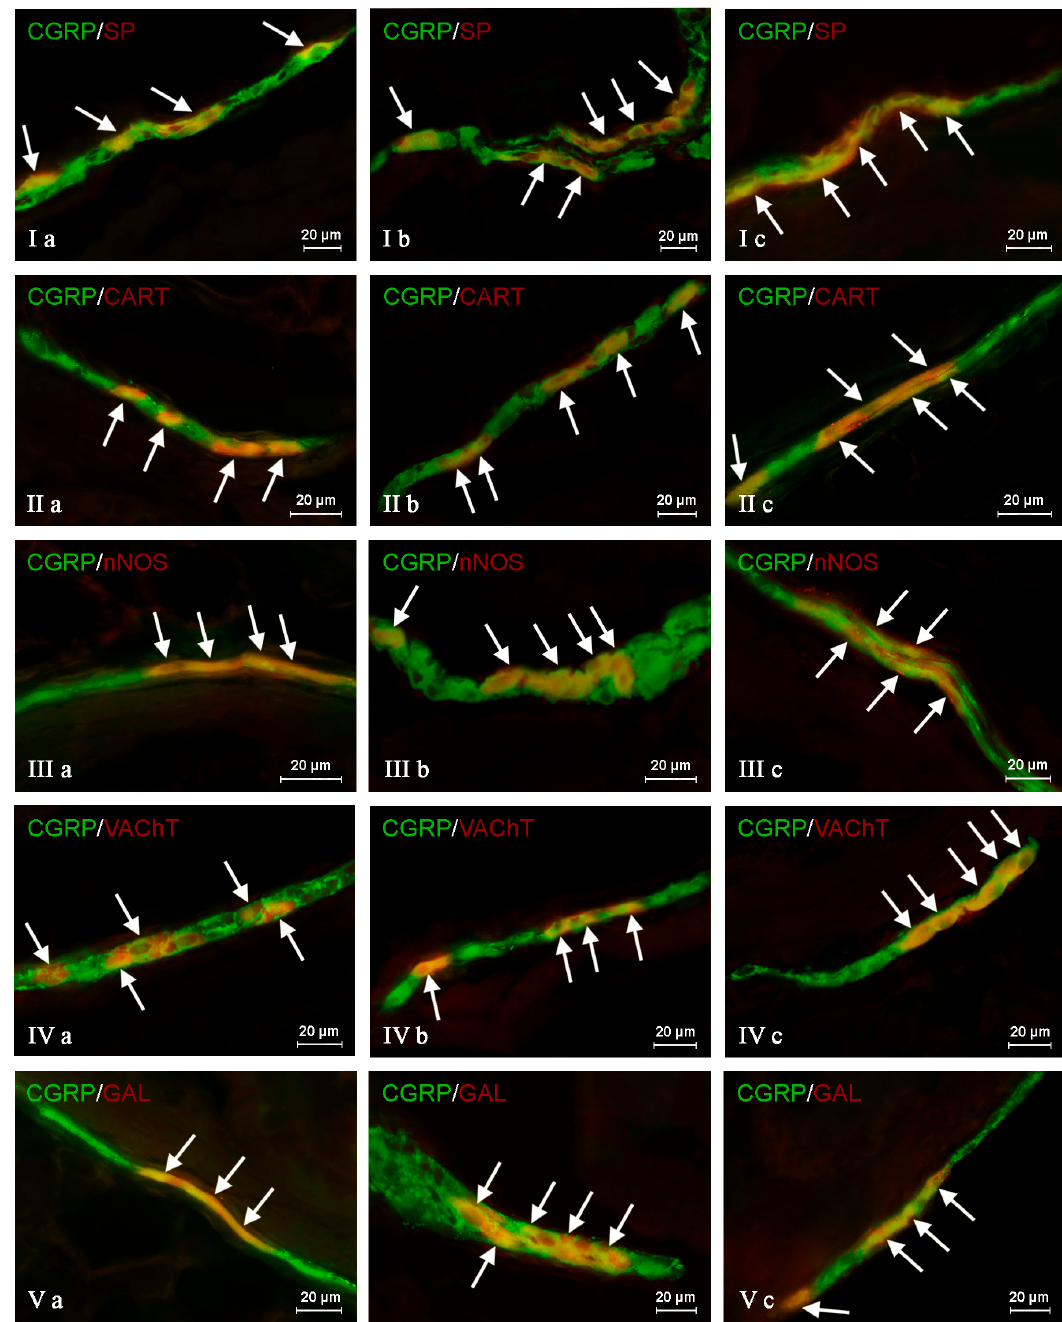
Figure 4. Representative images of the co-localization of calcitonin gene related peptide (CGRP) with other neuronally-active substances in the neurons of the outer submucous plexus of the porcine descending colon under physiological conditions ( a ), after axotomy ( b ) and during inflammation ( c ). (I) Co-localization of CGRP with substance P (SP); (II) co-localization of CGRP with cocaine- and amphetamine-regulated transcript (CART) peptide; (III) co-localization of CGRP with the neuronal isoform of nitric oxide synthase (nNOS); (IV) co-localization of CGRP with vesicular acetylcholine transporter (VAChT); (V) co-localization of CGRP with galanin (GAL). Images are composites of merged images taken separately from green (CGRP) and red (other substances studied) fluorescent channels. Nervous structures where CGRP co-localizes with other substances are indicated by arrows.